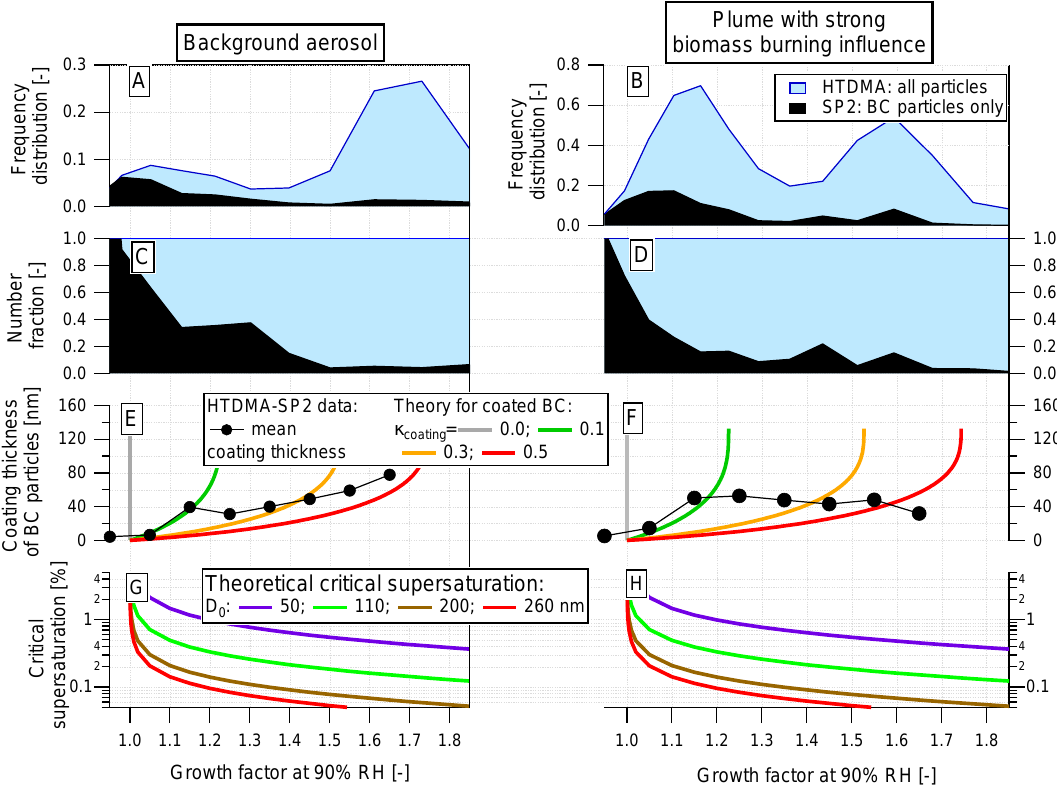
Fig. 15. Growth factor resolved properties of particles with a dry mobility diameter of D 0 = 265nm obtained during the coupled HTDMA- SP2 setup for background (left panels) dominated and biomass burning dominated (right panels) periods. Measured GF-PDF at 90%RH ( A and B ) for all particles (blue shading) and BC-containing particles (black shading). Number fraction of particles ( C and D ) with a BC core (black shading) and without a BC core (blue shading). Mean coating thickness of non-refractory matter on the BC cores (black circles; E and F ). Theoretical GF as a function of coating thickness ( E and F ) for coating made of hydrophobic material (grey line), oxidised organics (green line), mixed organic/inorganic (orange line) and sulphate (red line). Theoretical critical supersaturations necessary for CCN activation, as a function of growth factor and dry diameters (colour code in G and H